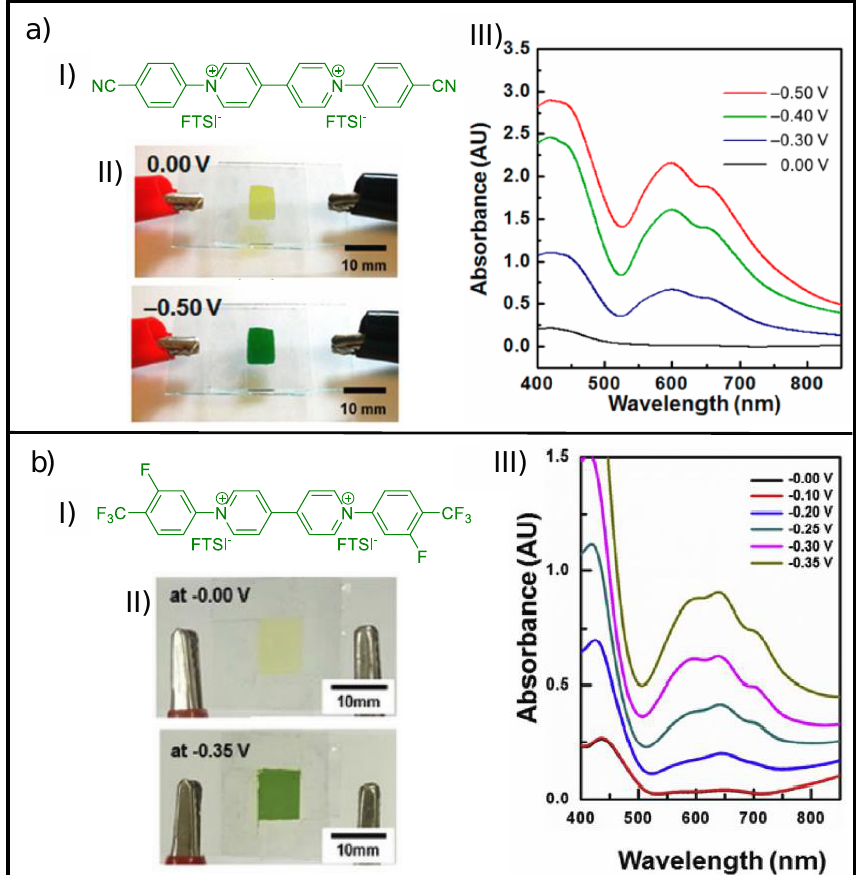
Figure 6. ( a ) ECD comprising 1,1′-bis-( p- cyanophenyl)-4,4′-bipyridilium bis(trifluoromethylsulfonyl)imide, ( p -CV (FTSI) 2 ): ( I ) Chemical structure of ( p -CV (FTSI) 2 ); ( II ) photographs of corresponding ECD for bleached state at 0.00 V and green-colored state −0.50 V and ( III ) variation of UV-Vis spectra at different applied voltages. ( b ) ECD comprising 1,1′-bis(3-fluoro-4-(trifluoromethyl)phenyl)-4,4′-bipyridinium bis(trifluoromethylsulfonyl)imide; ( I ) chemical structure of this viologen; ( II ) photographs of corresponding ECD for bleached state at 0.00 V and green-colored state −0.35 V, and ( III ) variation of UV-Vis spectra at different applied voltages. (a) Adapted with permission from [94], copyright (2016) American Chemical Society, and (b) adapted from [92], copyright (2017), with permission from Elsevier.